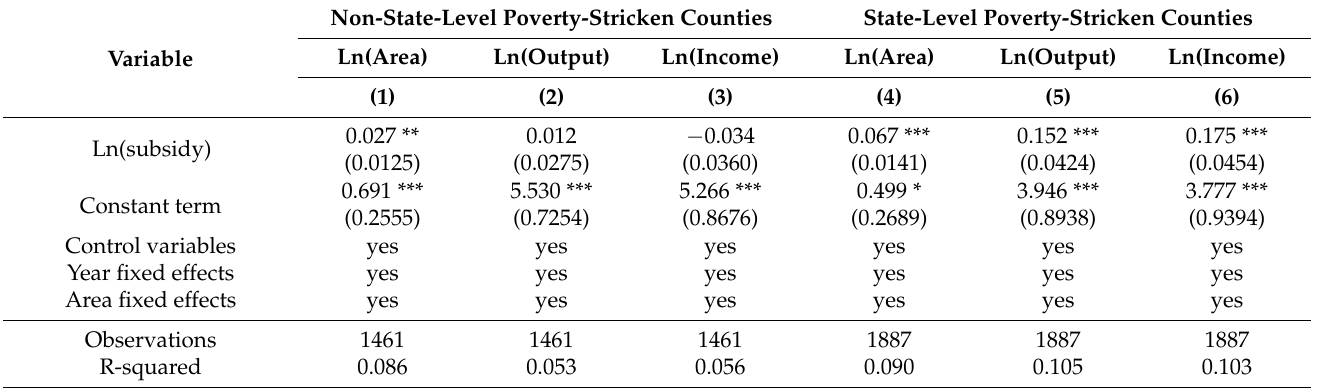
Table 6. Regression results of distinguishing state-level and non-state-level poverty-stricken counties.